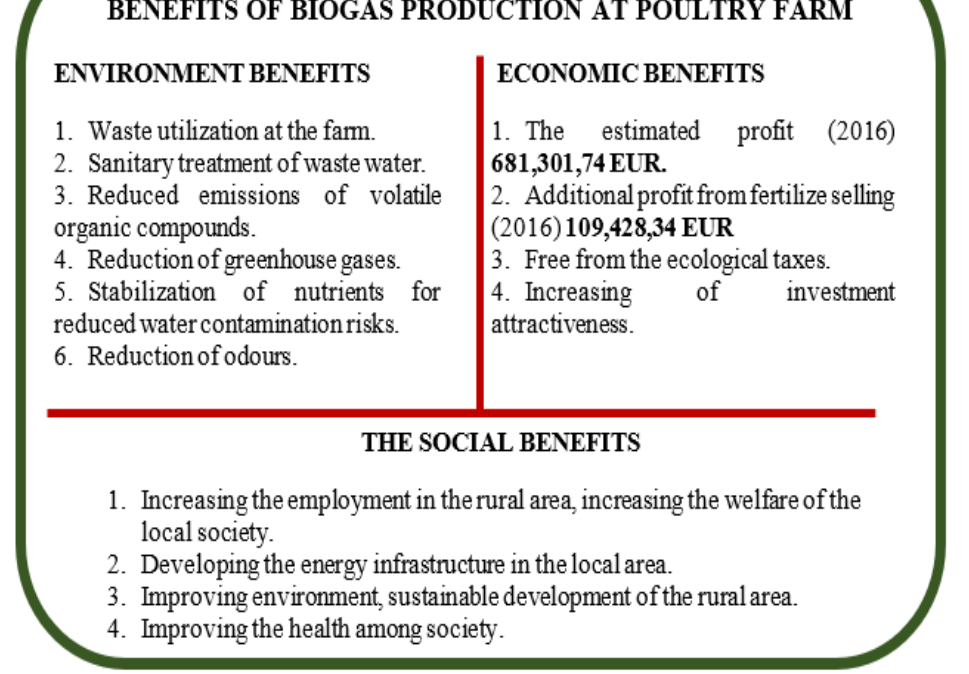
Fig. 2. Environmental, social and economic benefits from biogas production at the poultry farm “Avis Ukraine” Source: Formed by the